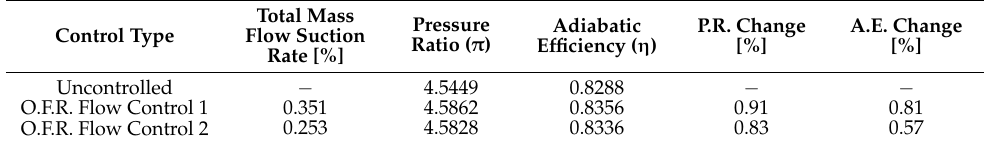
Table 3. Numeric results of the suction flow control study for operation flow